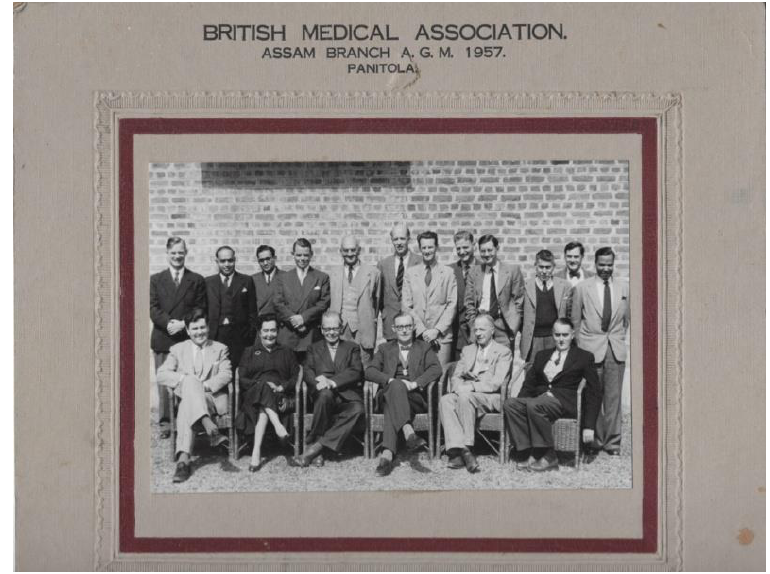
Figure 7. Dr. J.M.G. Wilson, 7th from the left back row and Prof Höjer, 3rd from left front row, at a meeting of the Assam branch of the British Medical Association in Panitola, Dribrugarh.